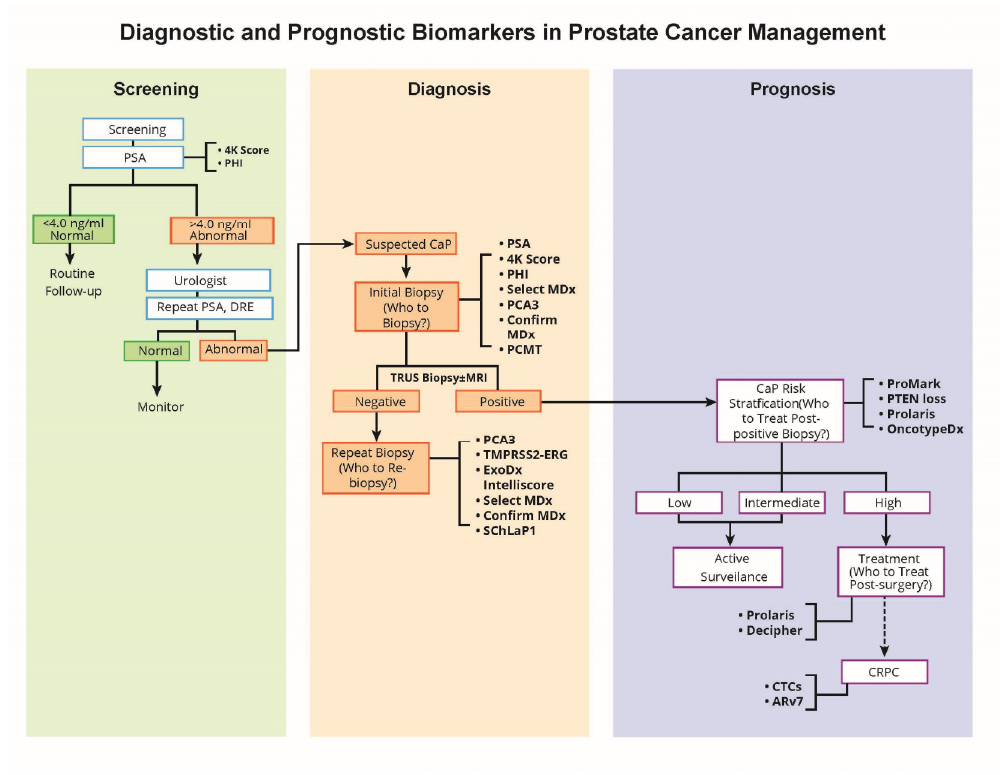
Figure 1. Role of biomarkers in prostate cancer management.